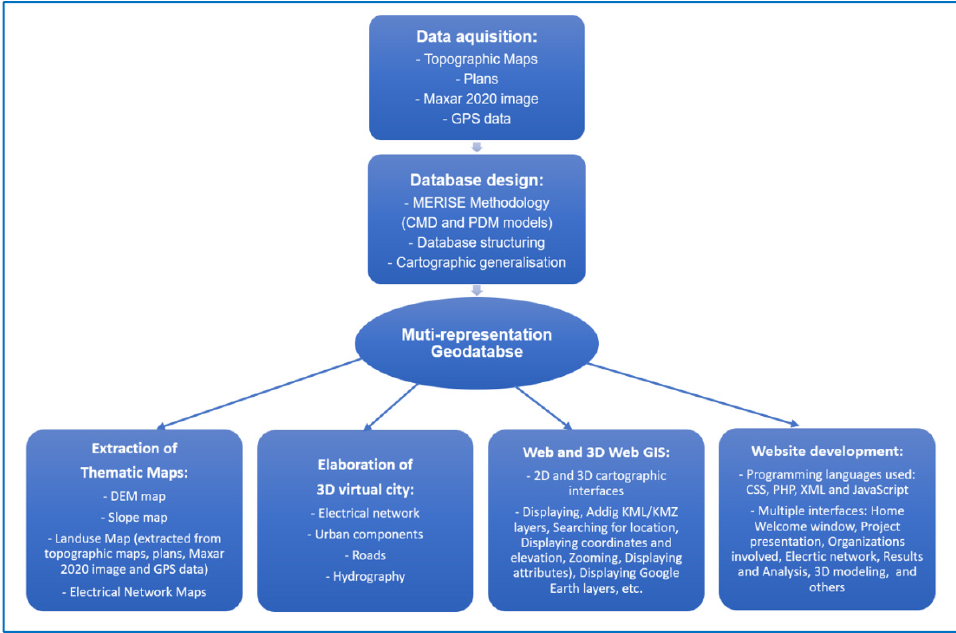
Figure 12. Graphical summary showing different methodology steps.